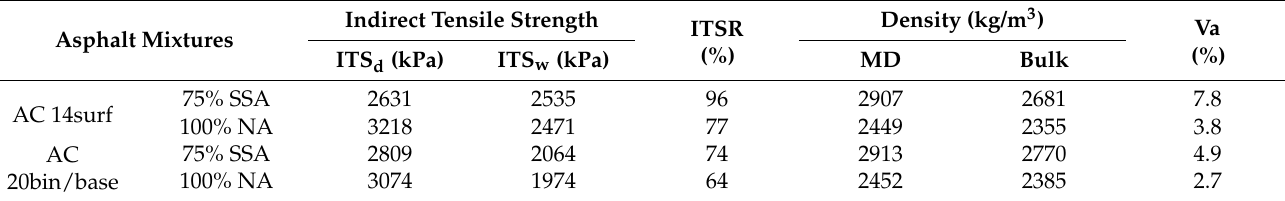
Table 11. Water sensitivity test results for mixtures with 75% SSA and natural aggregates.